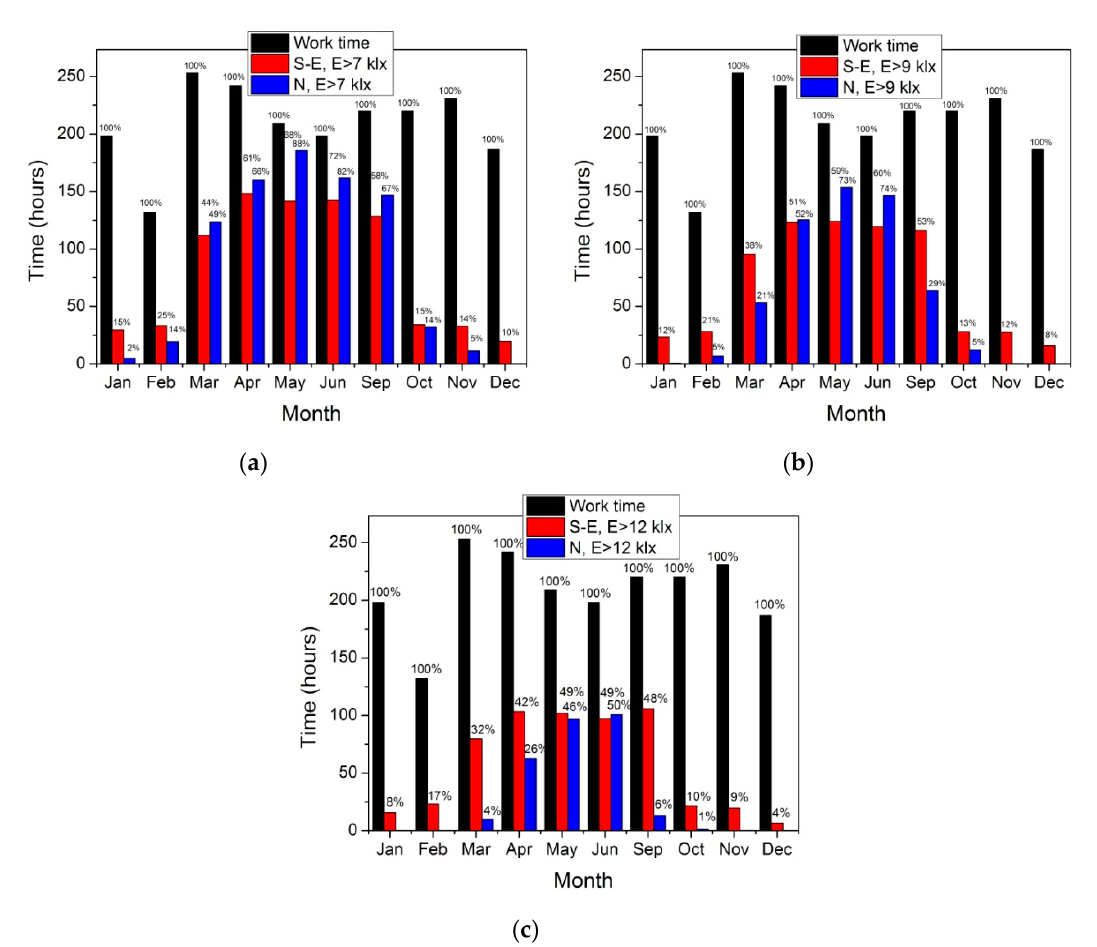
Figure 8. Number of hours in which the illuminance level outside the building exceeded the value of 7, 9, and 12 klx, on working days in April, from the south-east ( a ) and the north ( b ), and in September, from the south-east ( c ) and the north ( d ).